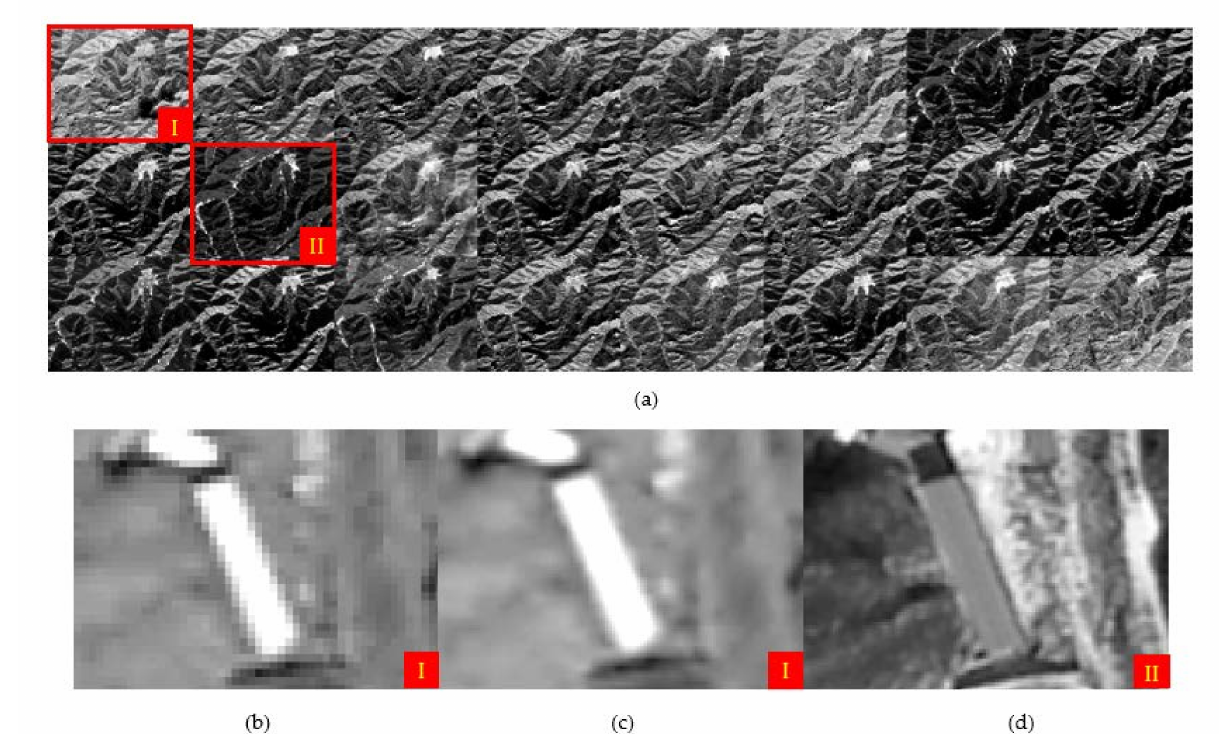
Figure 17. The mine areas of the remote sensing images from the GF-2 and GF-1 optical satellites. ( a ) The original image set. ( b ) A local magnification (32 × 40 pixels) of the GF-1 image; ( c ) The result of sampling on ( b ); ( d ) A local magnification (80 × 100 pixels) of the GF-2 image.